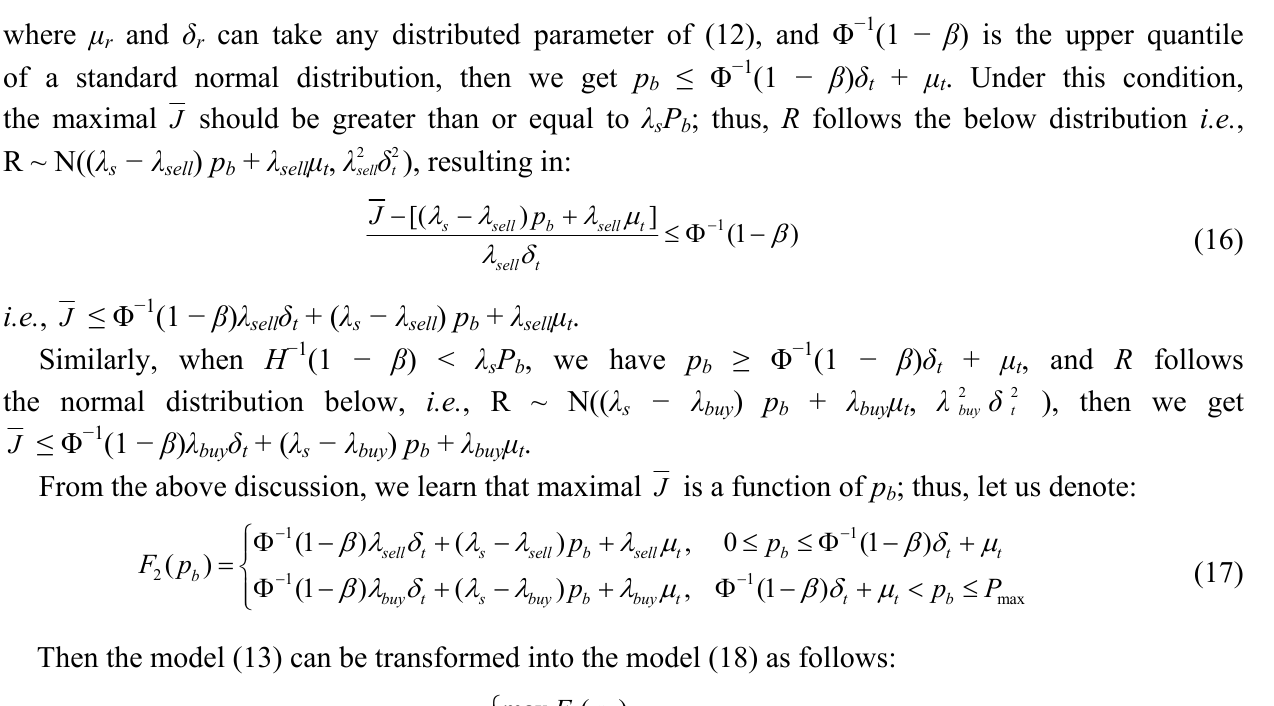
Figure 2. Function F